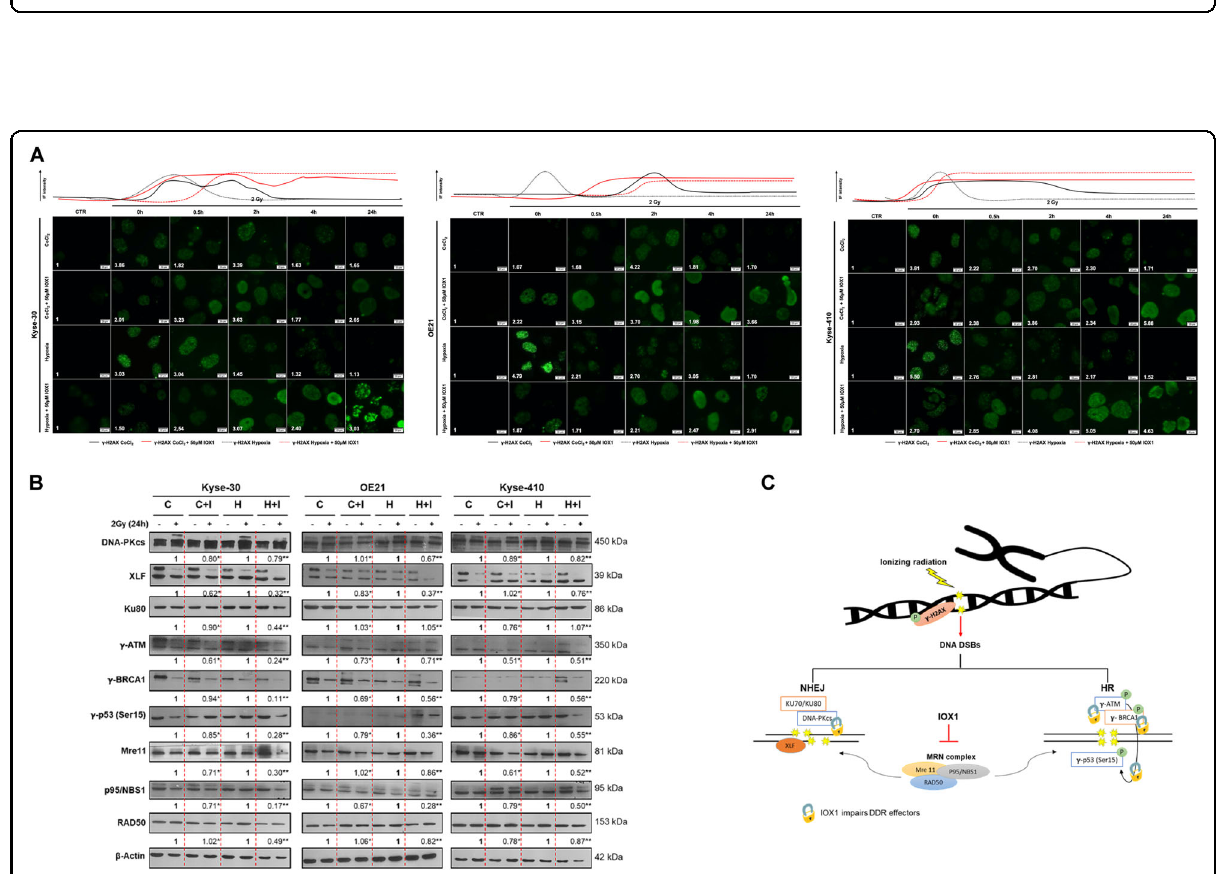
Fig. 4 Radiosensitizing effect of KDM3A knockdown in Kyse-410 ESCC cell line. a Representative images of total protein levels of KDM3A (70 – 150 kDa), H3K9me2 (17 kDa), and HIF-1 α (120 kDa) in KDM3A knockdown compared with scramble under normoxia and hypoxic conditions (50 µM CoCl 2 or 0 – 1% O 2 ). β -Actin (42 kDa) was used as loading control. b Representative IF pictures of co-localized nuclear DAPI (blue), KDM3A (green), and H3K9me2 (red) in KDM3A-KD and scramble, under normoxia and hypoxic conditions (50 µM CoCl 2 or 0 – 1% O 2 ). All pictures were taken with Olympus IX51 microscope at ×200 magni fi cation (scale bar 50 μ m). c Cell survival curves from Kyse-410 KDM3A-KD/Scramble cell lines irradiated with [0 – 8] Gy range IR dose fraction under 50 µM CoCl 2 and 0.5 – 1% O 2 hypoxic conditions through SHMT model analysis. Results are presented as mean ± SD of at least three independent experiments. d Cell proliferation ( e ) 24 h migration normalized to 0H and ( f ) cell apoptosis for combined KDM3A-KD/Scramble + 2 Gy irradiation under hypoxic conditions (50 µM CoCl 2 or 0 – 1% O 2 ). Fold changes were obtained after 2 Gy/0 Gy normalization. Results are represented as mean ± SD of at least three independent experiments; * p < 0.05; ** p < 0.01; *** p < 0.001; **** p < 0.0001. g DNA damage of 2 Gy irradiated Kyse-410 KDM3A-KD/Scramble cells between 0 and 24 h 50 µM CoCl 2 and hypoxia (0.5 – 1% O 2 ), by comet assay. Results refer to the mean values of at least 50 comets per condition. All values of DNA fragmentation (tail moment) were normalized to control (0 Gy). Fold change of relative values KDM3A-KD were compared to control scramble. h Representative pictures of nuclear γ -H2AX staining of 2 Gy irradiated Kyse-410 KDM3A-KD/Scramble cells (0 – 24 h) under 50 µM CoCl 2 and hypoxia (0.5 – 1% O 2 ). All pictures were taken with Olympus IX51 microscope at ×200 magni fi cation (scale bar 50 μ m). IF quanti fi cation was done using ImageJ software (version 1.6.1, from National Institutes of Health) and represented as a fold change between 2 Gy irradiated cells and non-irradiated control. IF, fl uorescence intensity.